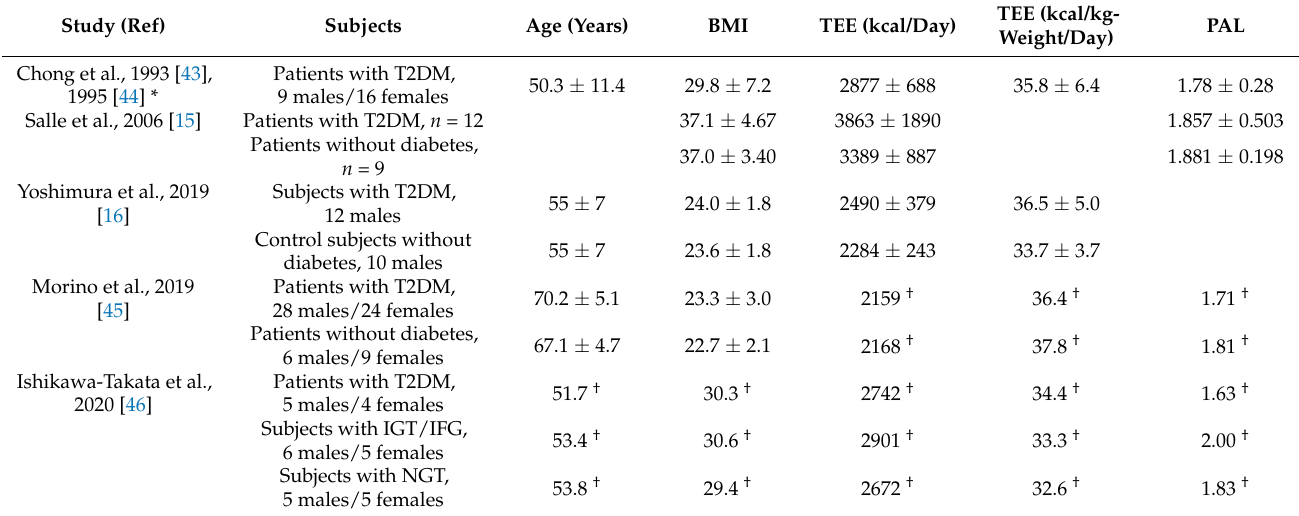
Table 1. Total energy expenditure of patients with type 2 diabetes mellitus assessed using the doubly labeled water method. Study